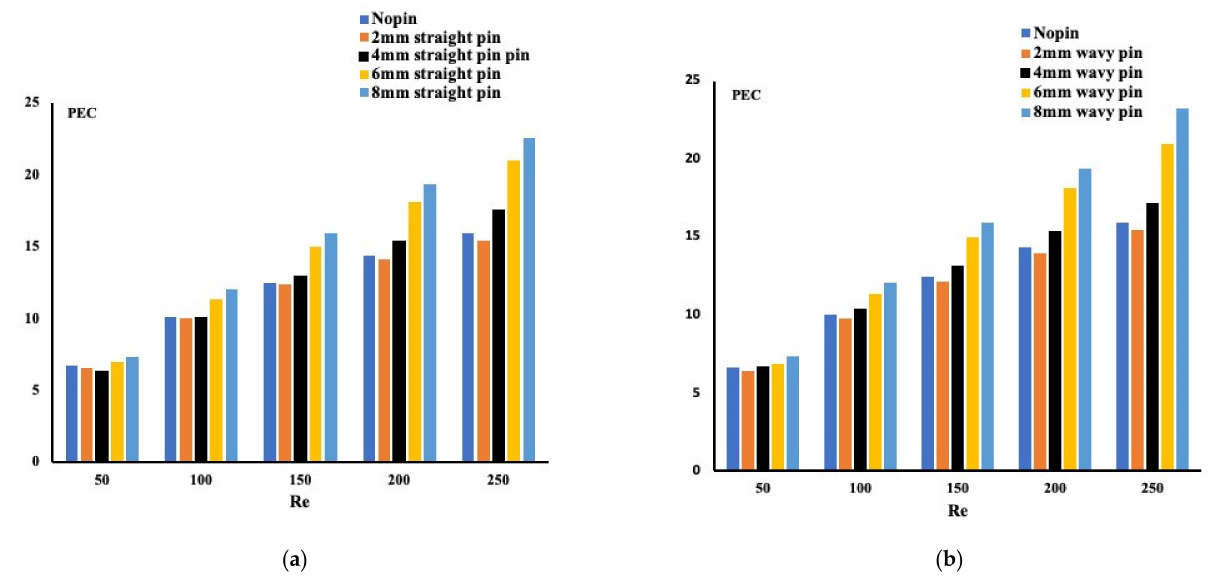
Figure 5. Performance evaluation criterion for different configurations (( a ) Straight pin-fins configu- ration, ( b ) Wavy pin-fins configuration).